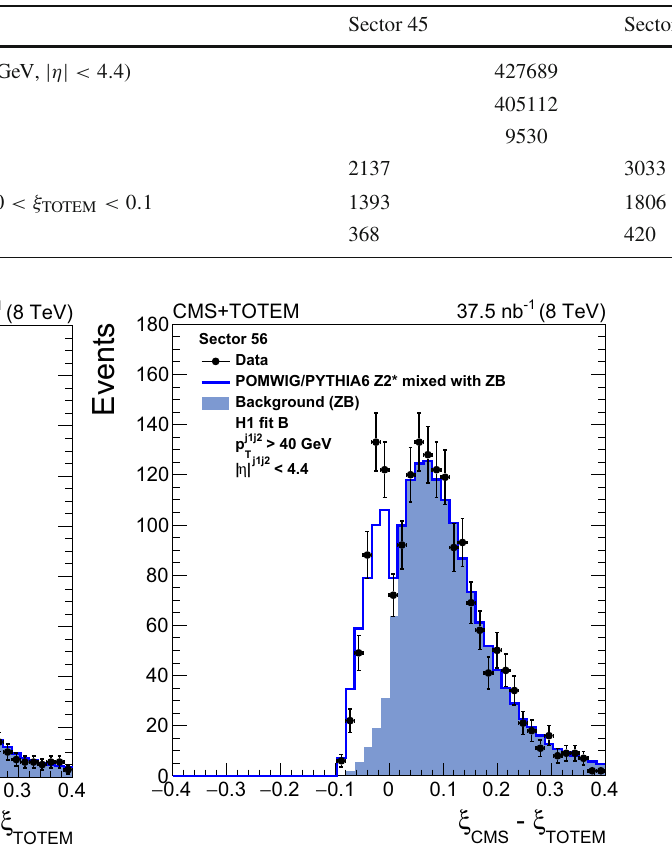
Fig. 2 Distribution of ξ CMS − ξ TOTEM for events with a reconstructed proton in sector 45 (left) and sector 56 (right). The data are indicated by solid circles. The blue histogram is the mixture of pomwig or pythia6 and zero bias (ZB) data events described in the text. An event with a